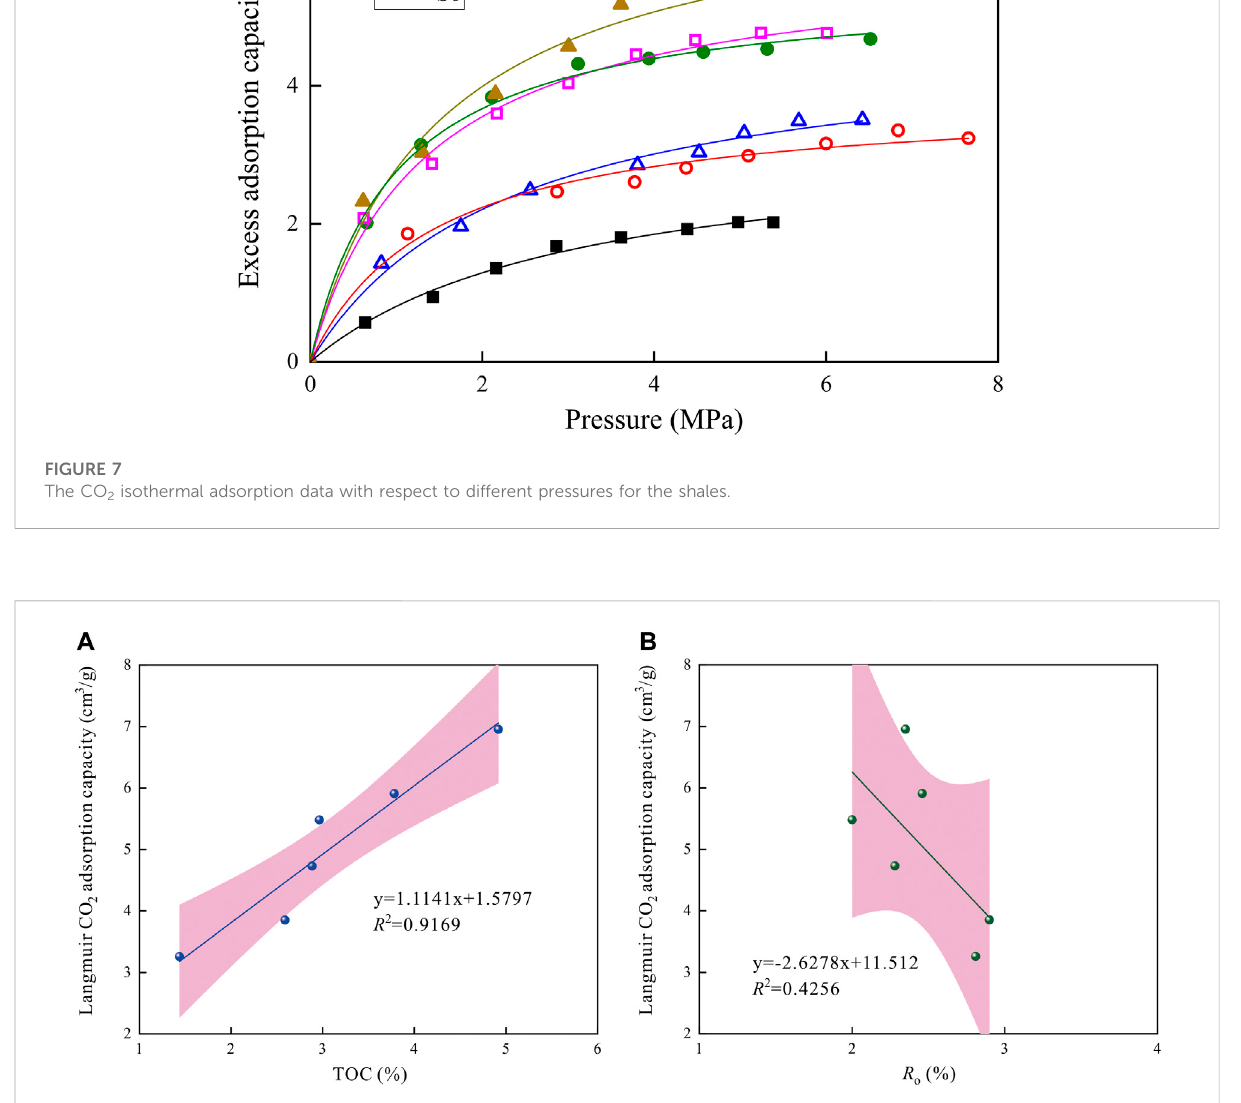
FIGURE 8 Relationships between TOC content, R o value and Langmuir CO 2 adsorption capacity in